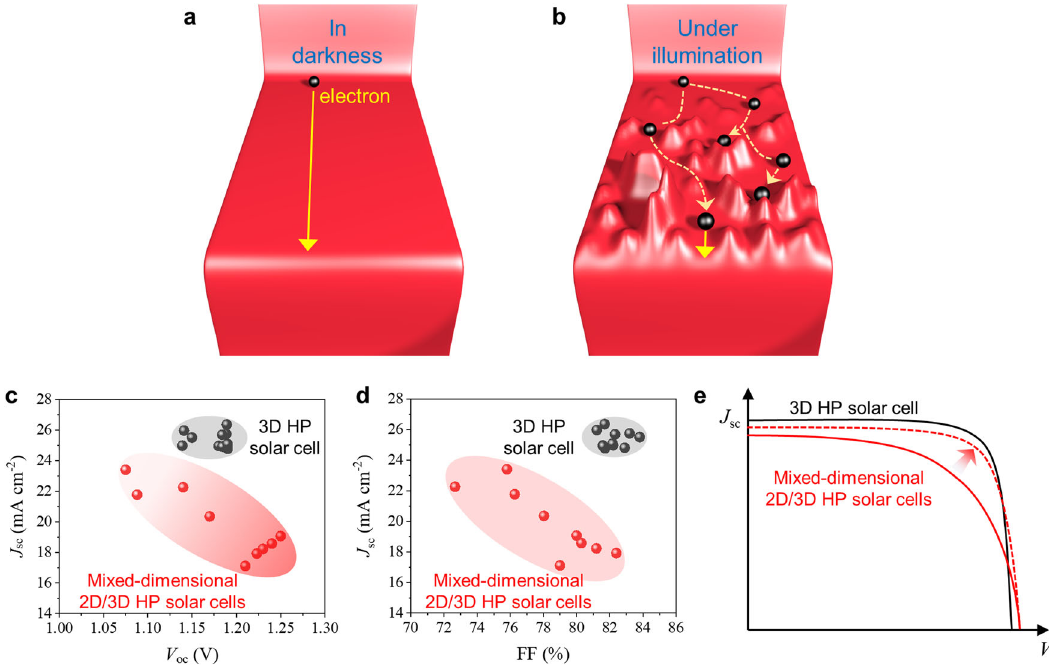
Fig. 7 | How the PCB effect limits the solar cell performance. Schematic illus- tration of the carrier transport within mixed-dimensional 2D/3D HP fi lms a in darkness and b under illumination. c , d The comparison of V oc , FF, and J sc between the top mixed-dimensionalsolar cells 13 – 19,21,23 , and the best-performing 3DHPsolar cells in literature 52 – 62 . e Illustrative J-V characteristics of the 3DHP solar cells(black